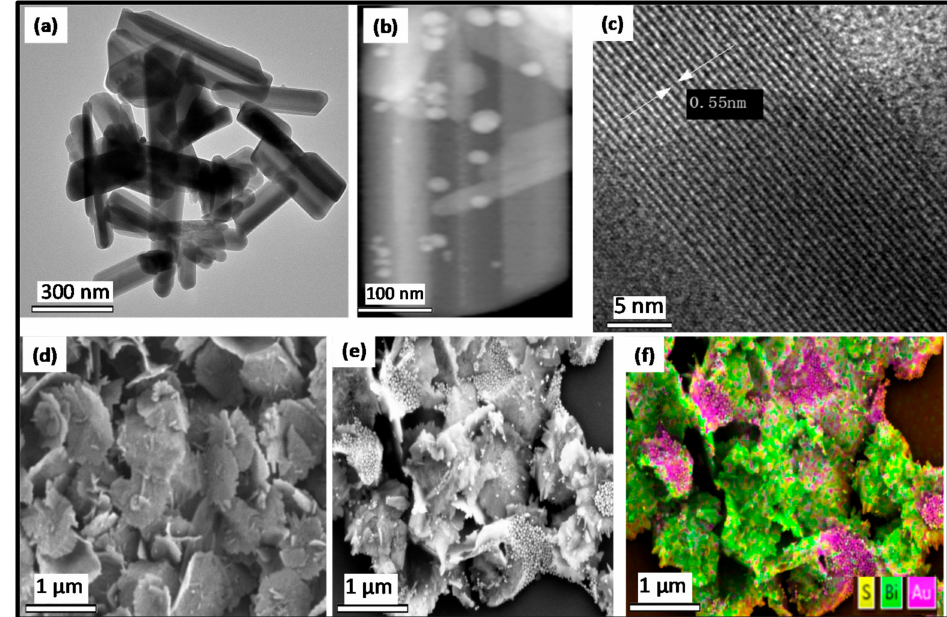
Figure 2. (Top) TEM image of rod-shaped Bi 2 S 3 nanocrystals (BNR) ( a ), bright field TEM for BNR-Au ( b ), HRTEM ( c ) for BNR. (Bottom) SEM images for flower-shaped Bi2S3 nanocrystals (BNF) ( d ), BNF-Au ( e ), elemental mapping for BNF-Au ( f